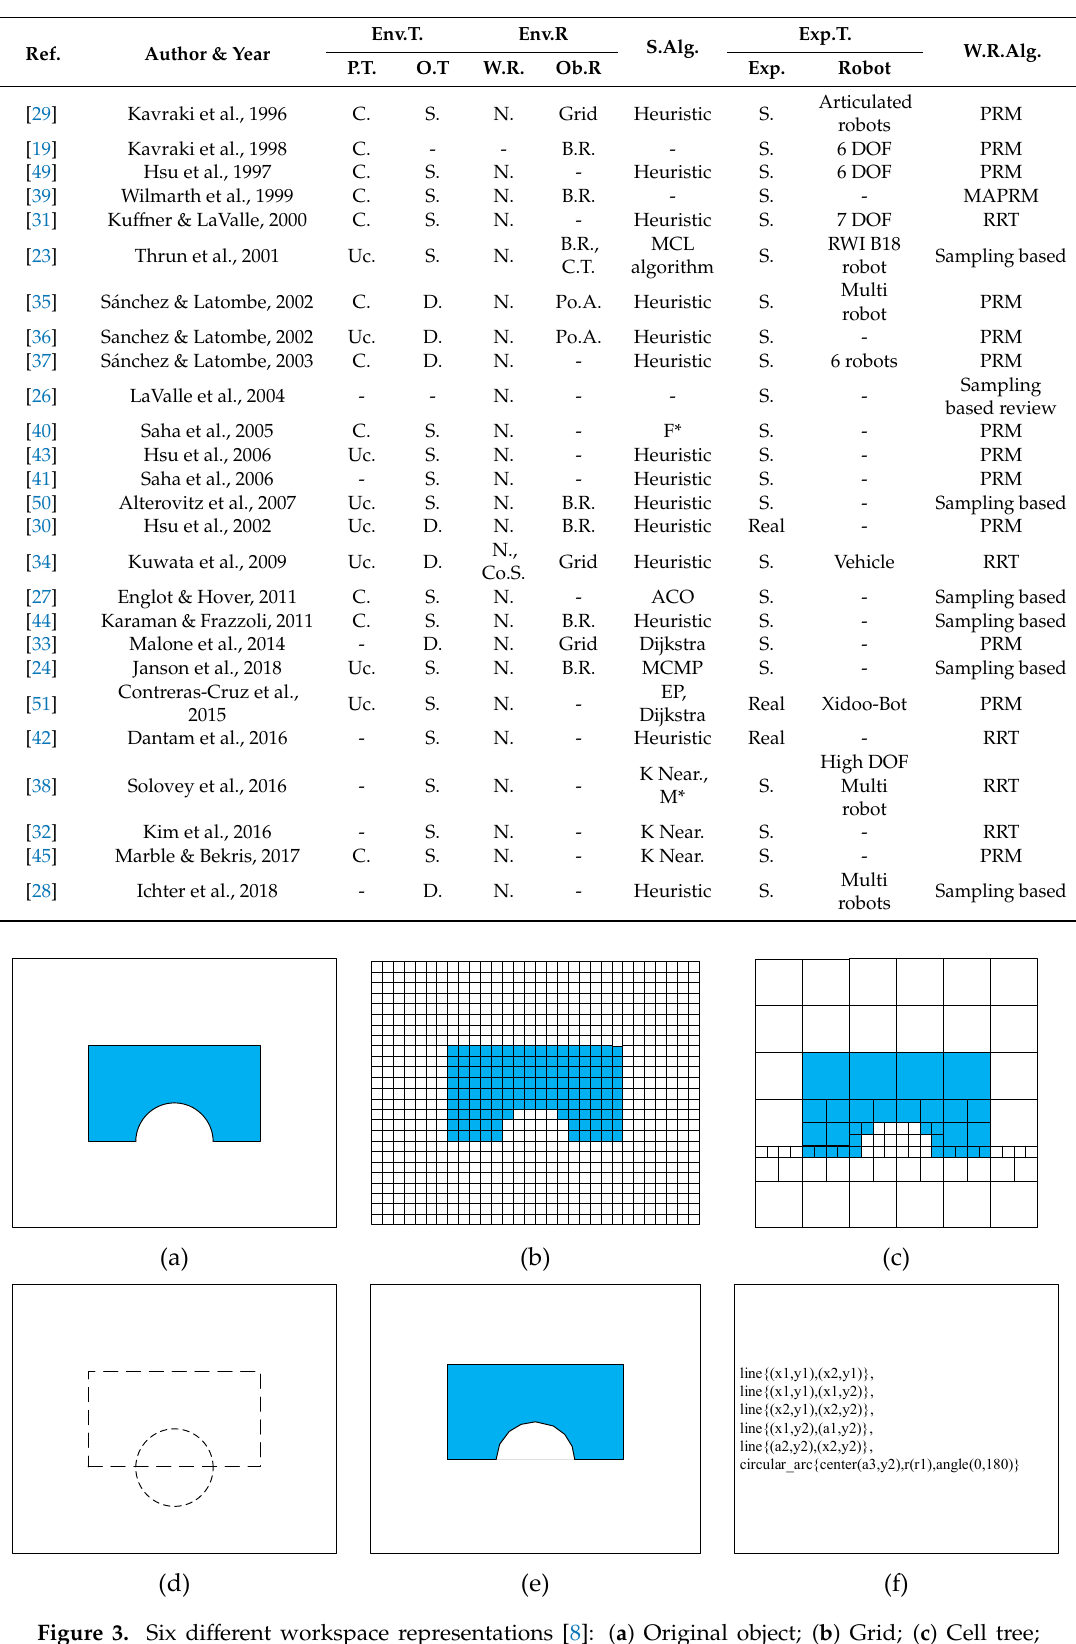
Figure 3. Six different workspace representations [8]: ( a ) Original object; ( b ) Grid; ( c ) Cell tree; ( d ) Constructive solid geometry; ( e ) Polygonal approximation; and, ( f ) Boundary representation.